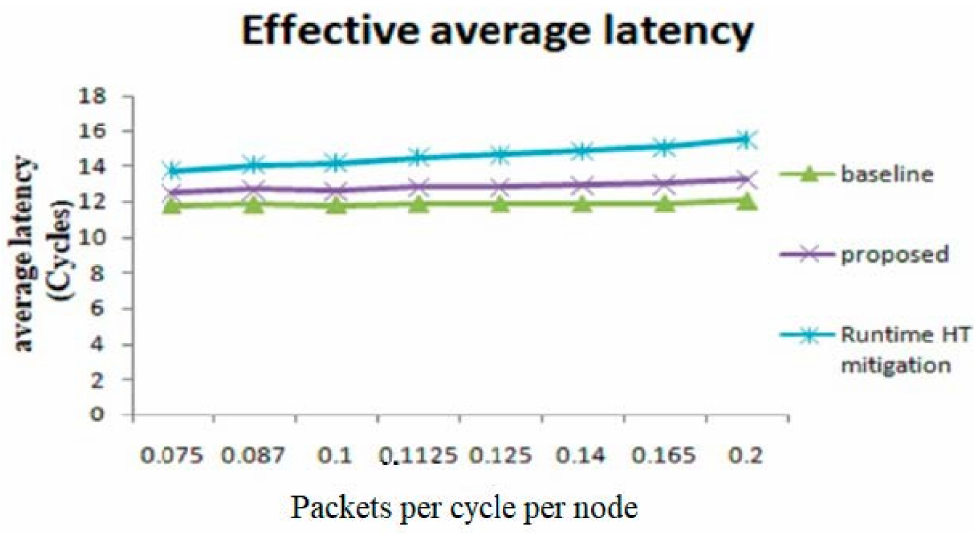
Figure 13. Effective average